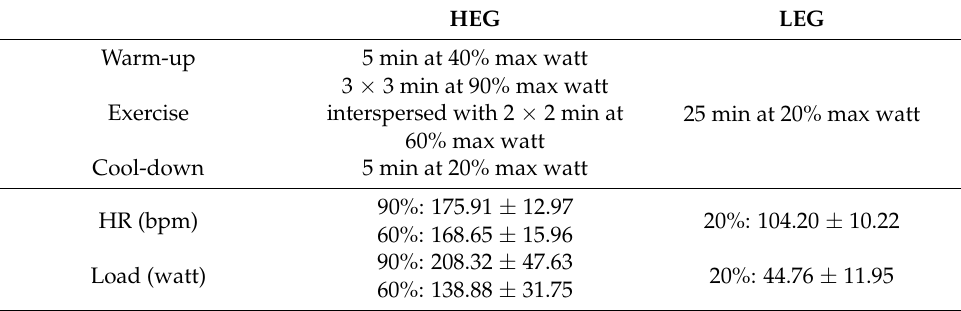
Table 2. Acute exercise protocols for the high-intensity exercise group (HEG) and low-intensity exercise group (LEG), and details (mean and SD ) of heart rate (HR) and physical load during both exercise conditions. HEG LEG Warm-up 5 min at 40% max watt 3 × 3 min at 90% max watt interspersed with 2 × 2 min at 25 min at 20% max wattExercise 60% max watt Cool-down 90%: 175.91 ± 12.97 20%: 104.20 ± 60%: 168.65 ± 15.96